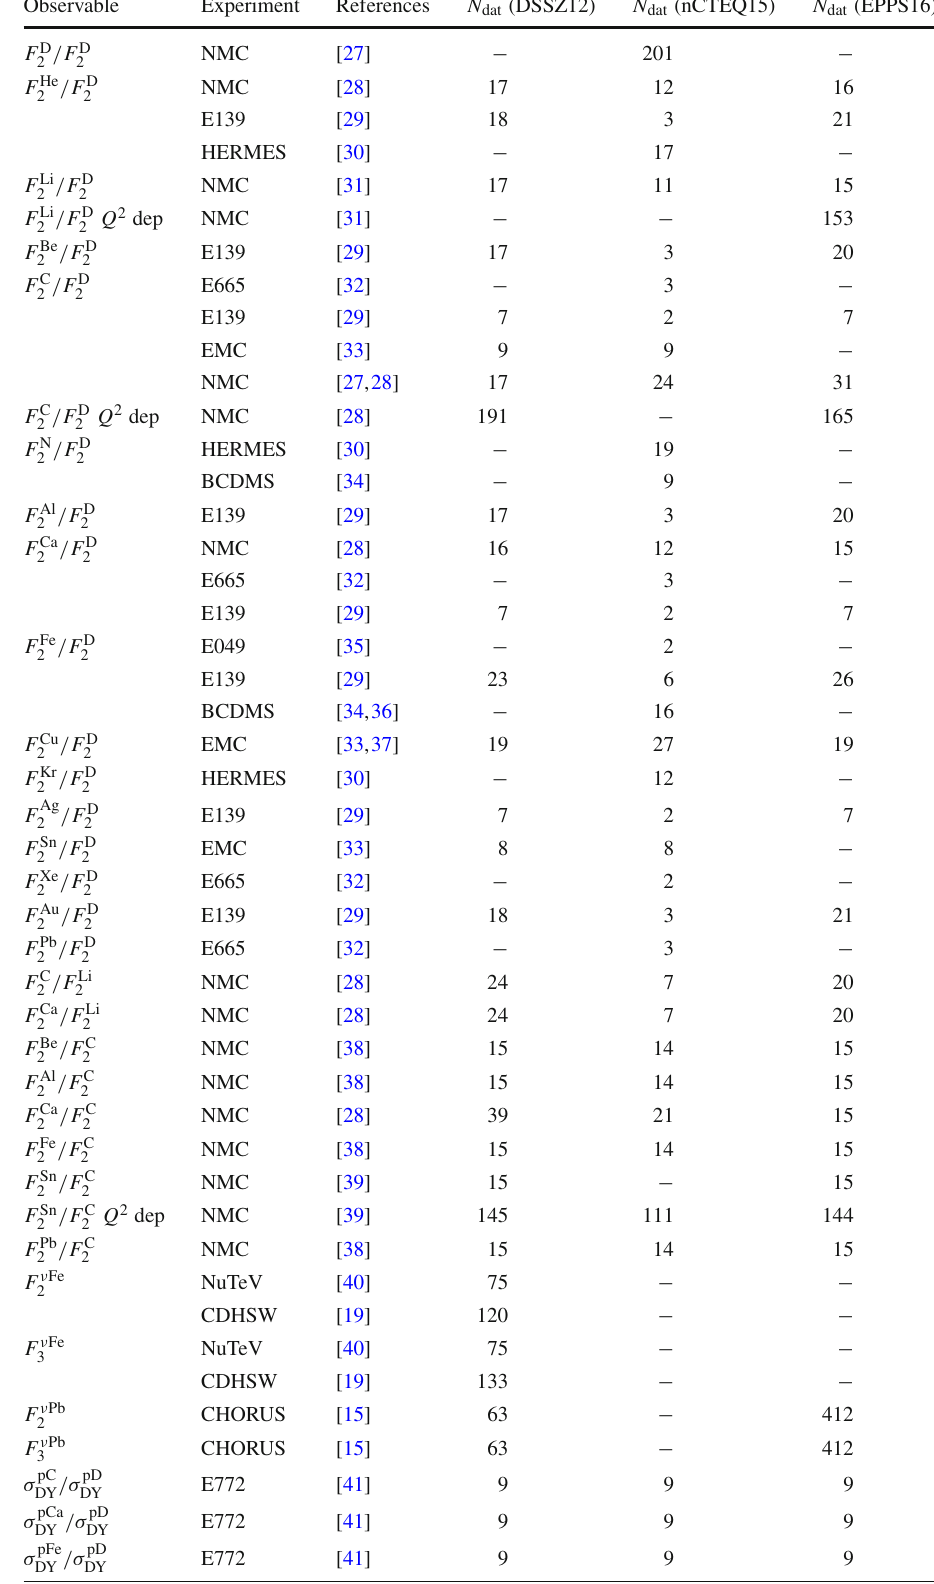
data entering the nPDF sets used in this